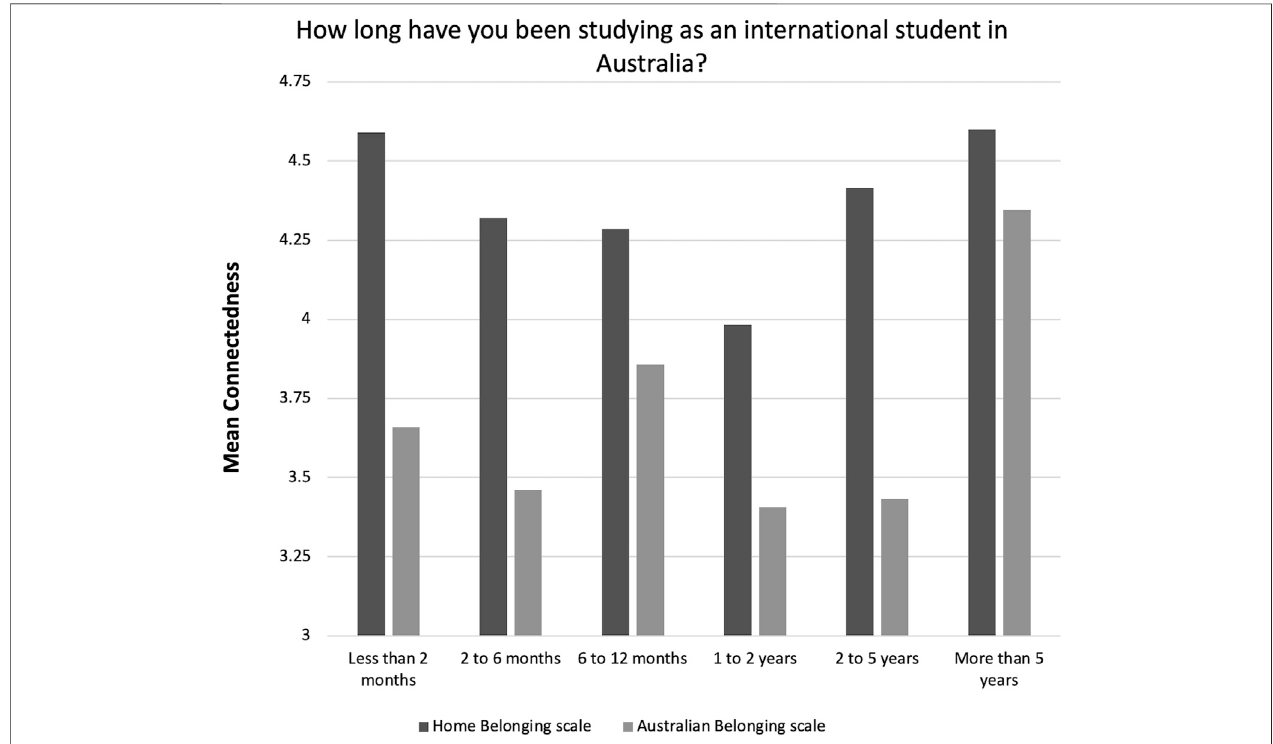
FIGURE 1 | Home and Australian connectedness for different time spent in